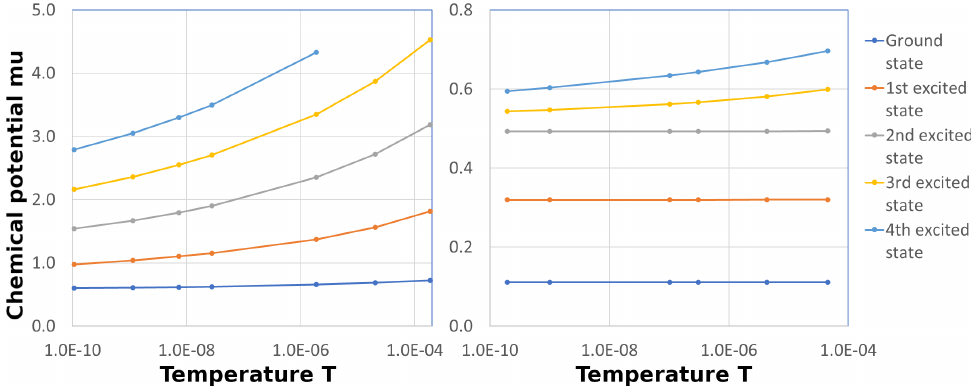
Figure 3 . The chemical potential µ where the ground and first four excited states appears when T decreases, plotted for two cases L = 1 (left) and L = 9 (right). The threshold µ are limits of these curves at T → 0 . Notice the horizontal log scale, and how µ does not plateau yet for many excited states, especially in the L = 1